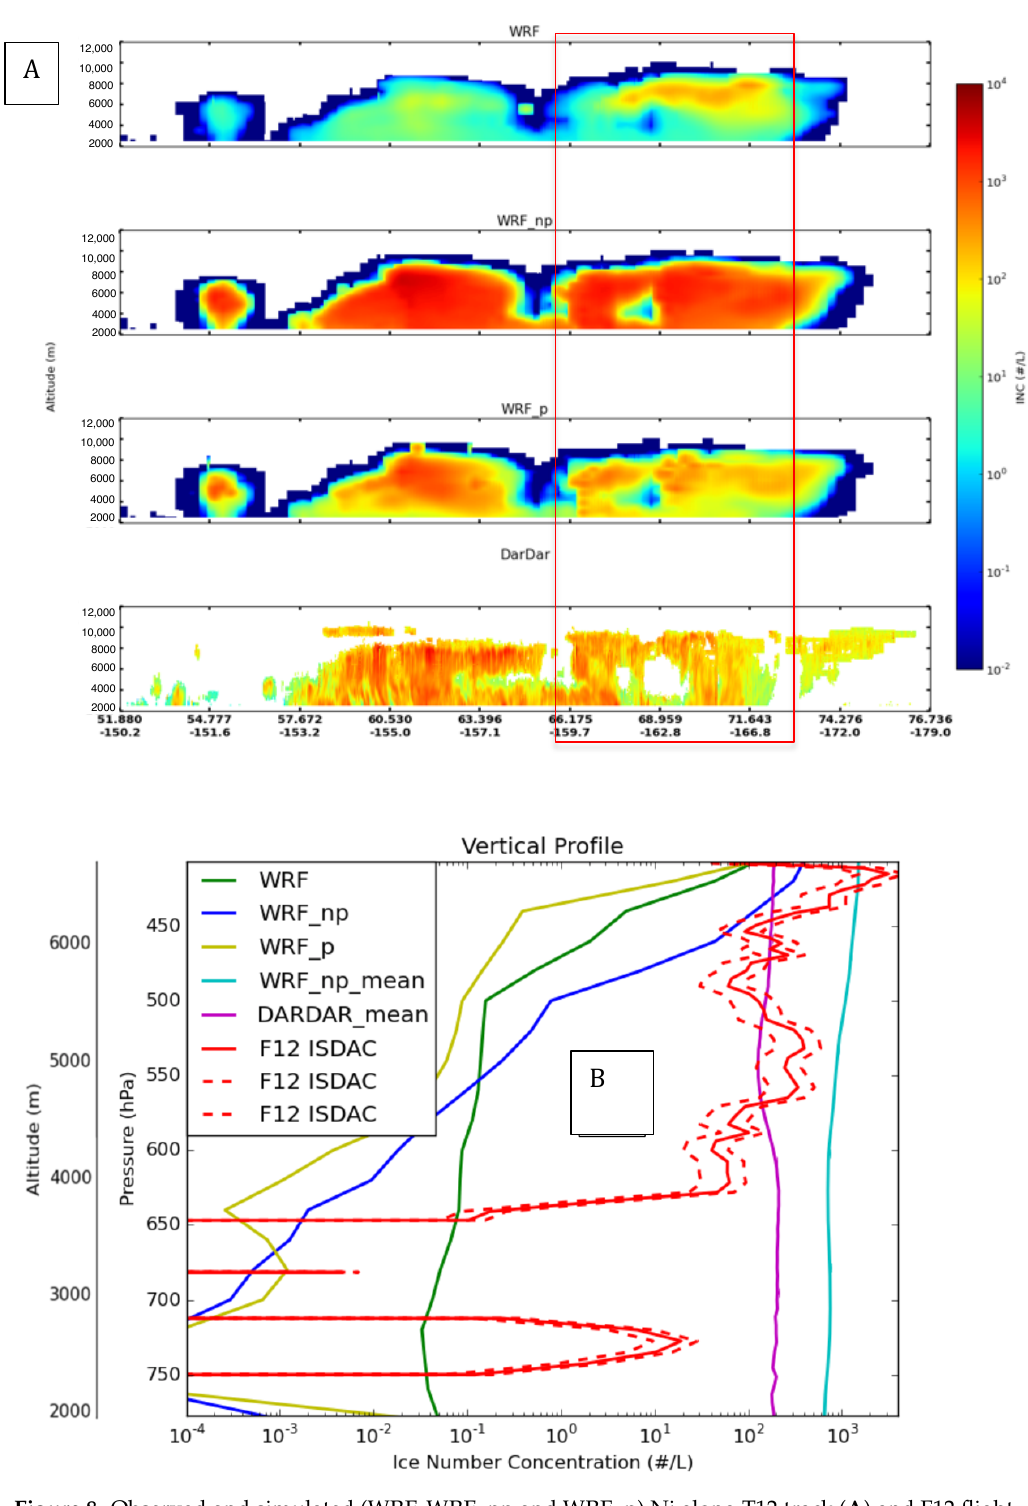
Figure 8. Observed and simulated (WRF, WRF_np and WRF_p) Ni along T12 track ( A ) and F12 flight ( B ). Simulated profile (WRF_ np_mean) averaged along the satellite track over the larger domain of Figure 1 is also shown on ( B ) together with DARDAR-retrieved average profile. The dashed red line on (B ) represents the variability (standard deviation) of ISDAC